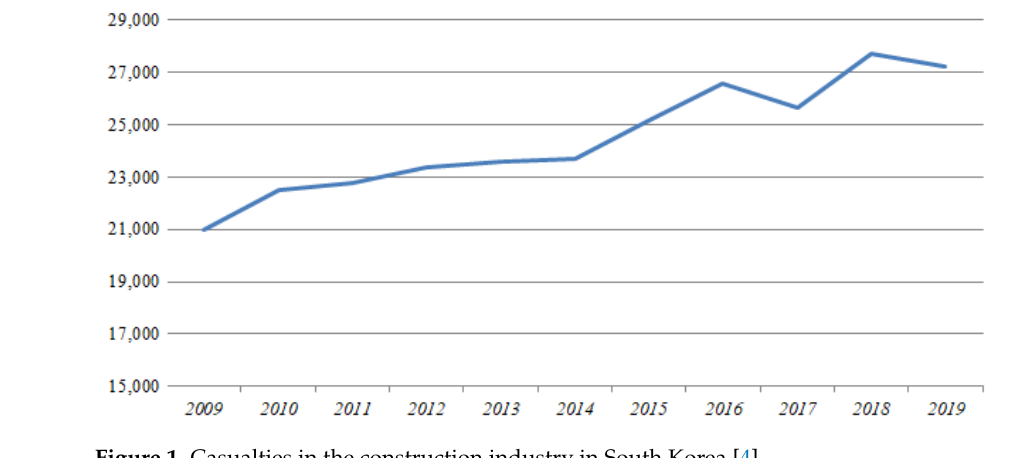
Figure 1. Casualties in the construction industry in South Korea [4].